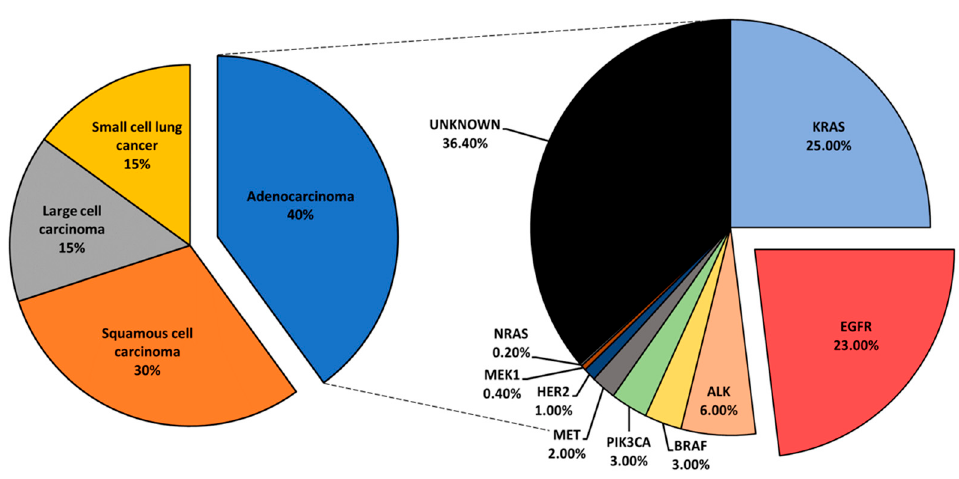
Figure 1. An overview of lung cancer histology and driver mutations in adenocarcinoma